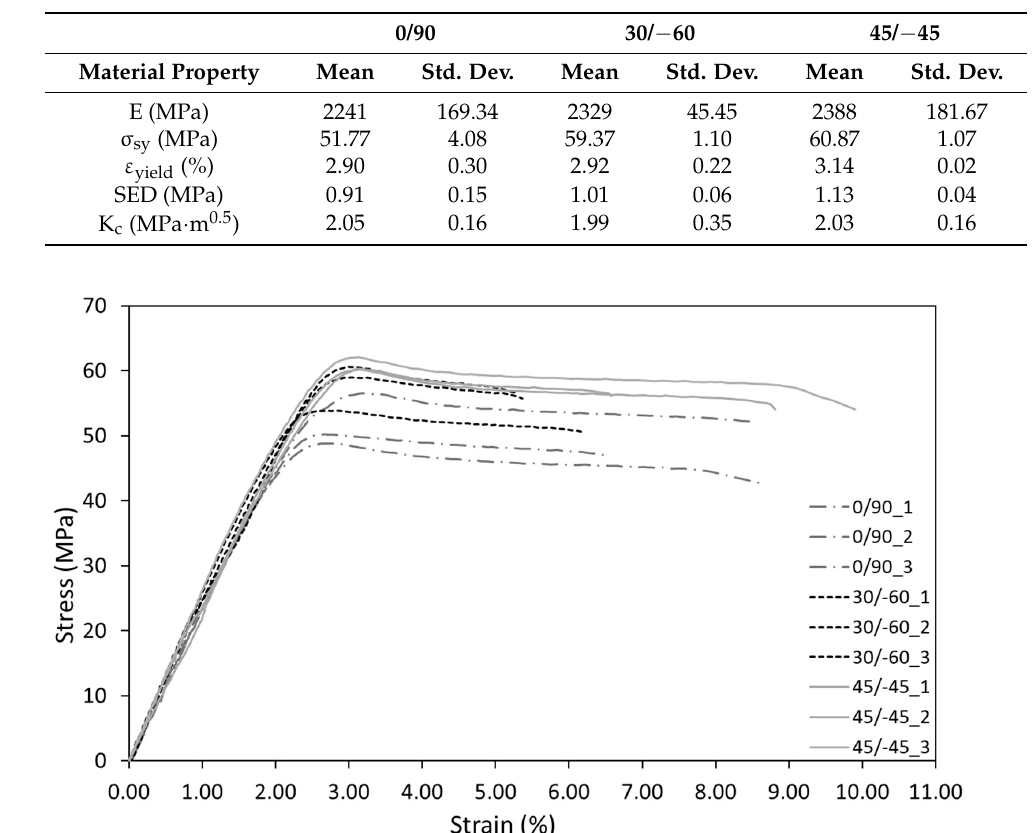
Figure 5. The stress-strain curves of the AM ABS material for the three different raster orientations.